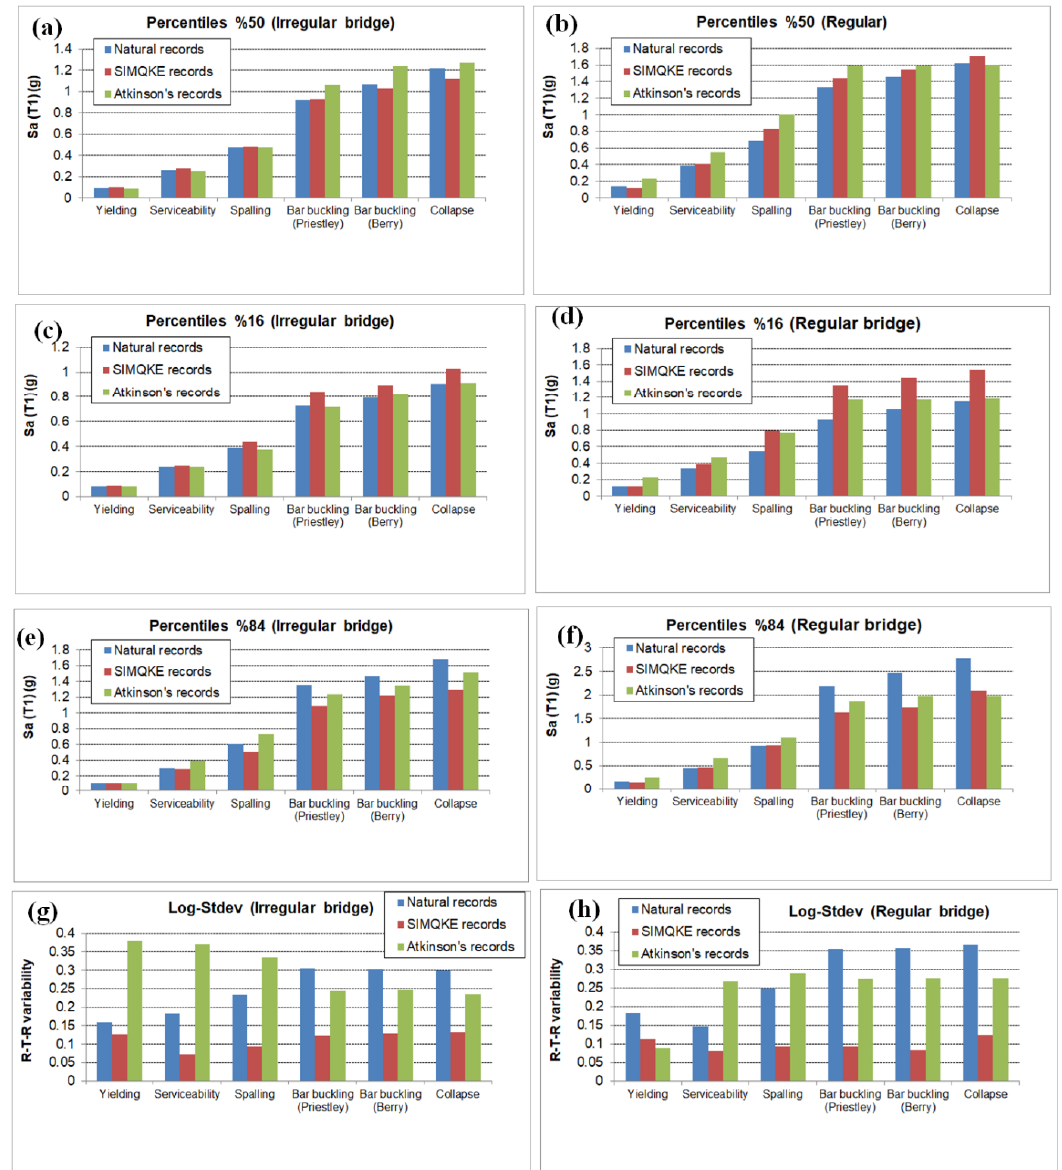
Figure 15. Comparison of the IDA results for the regular and irregular bridges in terms of: ( a , b ) 50% percentiles, ( c , d ) 16% percentiles, ( e , f ) 84% percentiles and ( g , h ) variability at different damage states for the irregular and regular bridges, respectively.